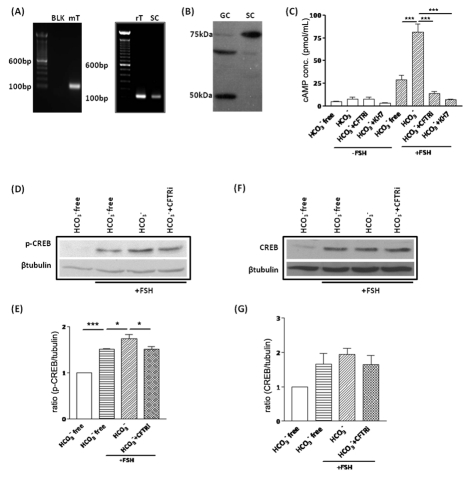
Involvement of CFTR-mediated HCO3
−
transport in FSH-stimulated cAMP production and CREB regulation.(A) RT-PCR result shows the expression of sAC in mouse
testis (mT), rat testis (rT) and primary Sertoli cells (SC) (expected
PCR product size: 119 bp). (B) Western blot shows the
expression of a 75 kD isoform of sAC in the Sertoli cells (SC). Adult
rat germ cell (GC) sample shows predominatly exression of 50 kD, with
another unidentified band. (C) Effect of
HCO3
−, CFTR and sAC inhibitors on 50 ng
FSH-stimulated cAMP production, with presence of 25 mM
HCO3
− potentiating FSH-stimulated cAMP
production in Sertoli cells, which is abolished by 10 µM
CFTRinh172 and 10 µM sAC inhibitor KH7.
(n = 3; ***:p<0.01).
(D-E) Effect of HCO3
− and
CFTR inhibitors on FSH-stimulated CREB phosphorylation. Western blot
results shows that 25 mM HCO3
− potentiates
50 ng FSH-stimulated CREB phosphorylation in Sertoli cells, while 10
µM CFTRinh172 attenuates the effect of
HCO3
− (n = 3;
*:p<0.05; ***:p<0.001). (F-G) Effect
of HCO3
− and CFTR inhibitor on CREB
expression. Western blot results shows that removal of
HCO3
− or treatment with CFTRinh172
slightly decrease total CREB level in the presence of FSH, but without
statistic significance (n = 3). Statistic data are
shown as mean±SEM. Detailed protocol in Materials and Methods.